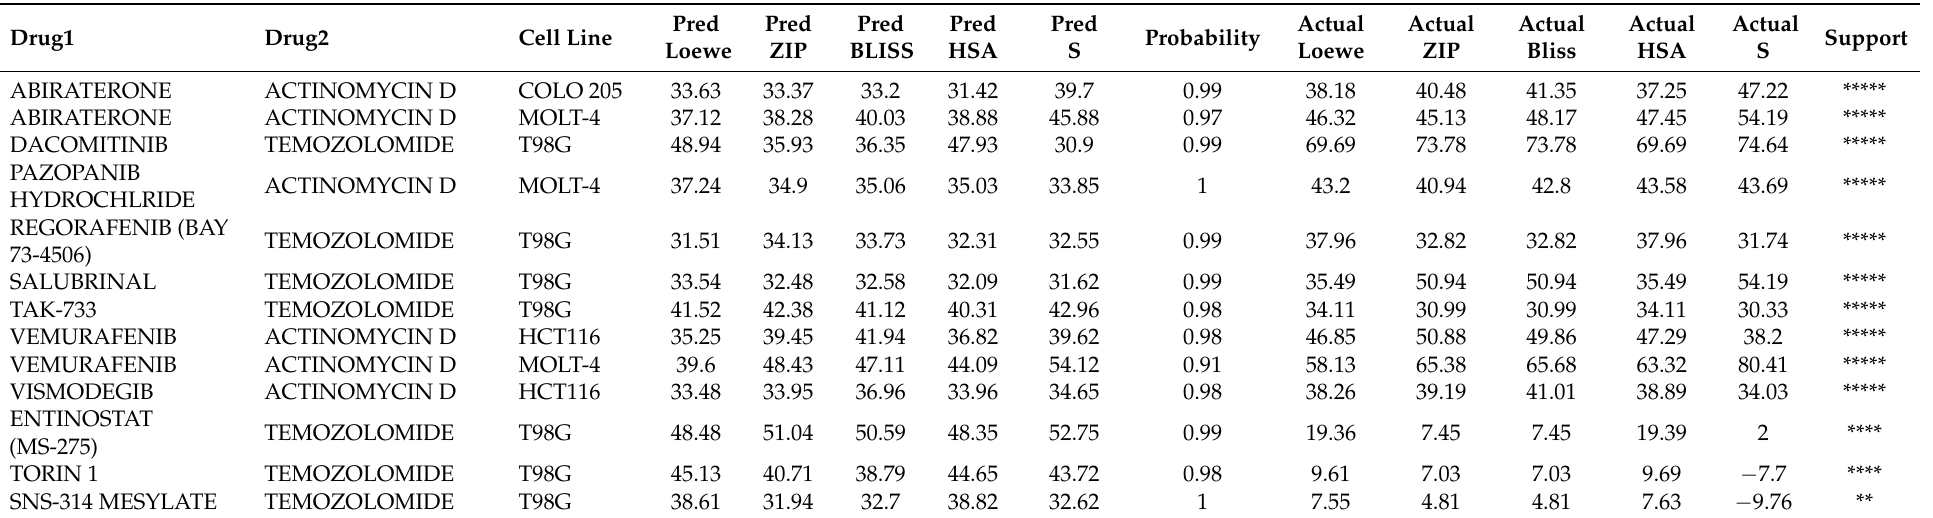
Table 5. The drug combinations with high predictive synergy scores in terms of all synergy